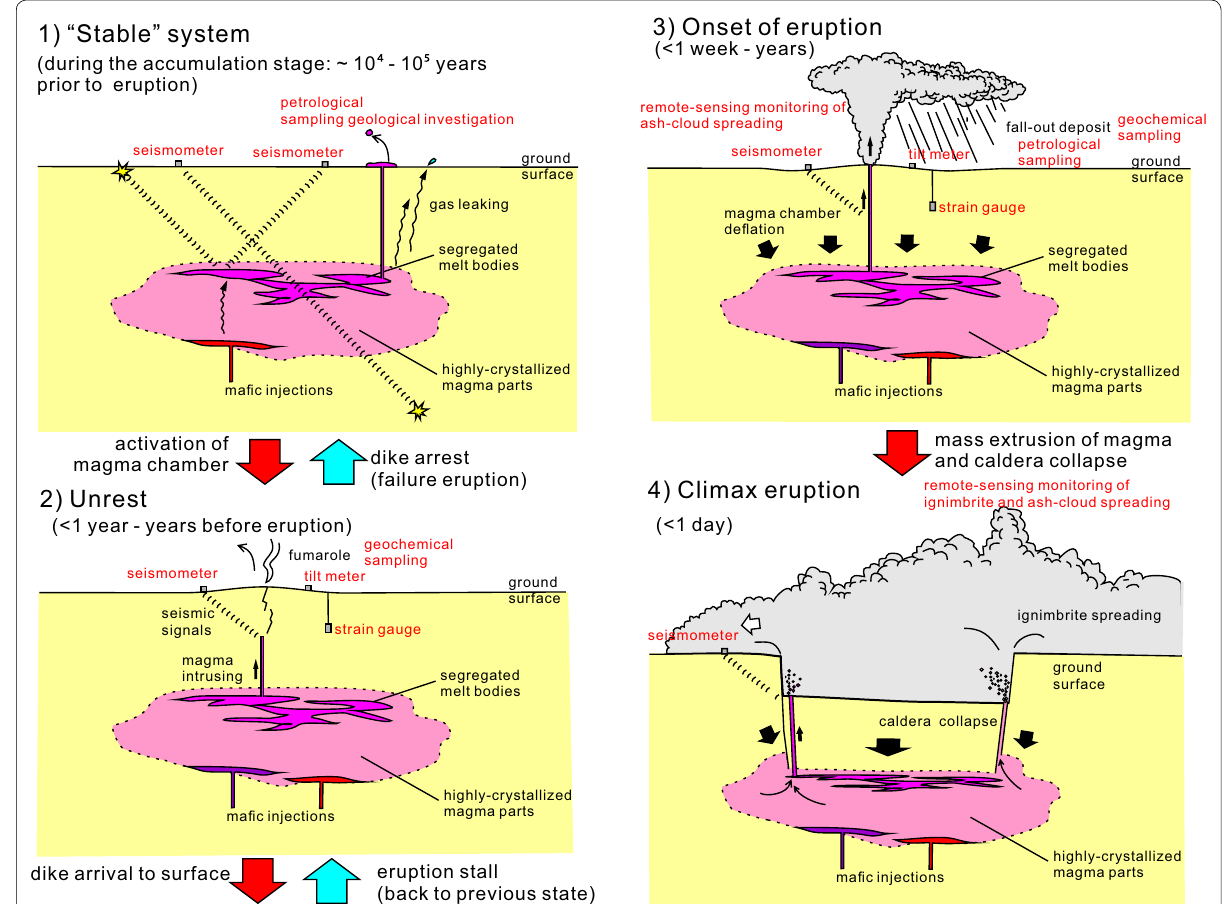
Fig. 2 Summary of volcanological phenomena associated with large-scale explosive eruptions and the methods used for their detection. (1) During the stable accumulation stage, detection of the magma chamber prior to eruption is crucial. Some geophysical explorations of massive liquid zones (potential magma chamber) can be useful. Geochemical and petrological investigations on the leaked materials (magma and gases) from the magma chamber also can be potential methods to monitor the state of magma chamber. (2) Diking from the activated magma chamber may cause “unrest” of the volcanic system. Detection of the ground deformation and seismic activities can detect the progress of diking from the magma chamber toward the ground surface. Geochemical investigations of fumarole gas and ground gas emission may be also useful. Eruption does not occur when the propagating dike is arrested within the host rock. (3) After onset of eruption, monitoring of the eruption cloud will be useful to detect the magma discharge rate. Syn-eruptive ground deformation also shows the deflation of magma chamber by magma extraction. Geochemical and petrological investigations on the erupted magma can provide direct information about the magma storage which is feeding the eruption. Many eruptions may stall by various factors and the system back to the previous state. (4) After the eruption reaches to climax eruption (VEI 6 or larger), rapid deflation of magma chamber results collapse of the roof of magma chamber which can be detected by geodetic data and seismic signals. Monitoring of the behavior of ignimbrite and co-ignimbrite ash fall by remote-sensing methods is useful for evaluating widespread